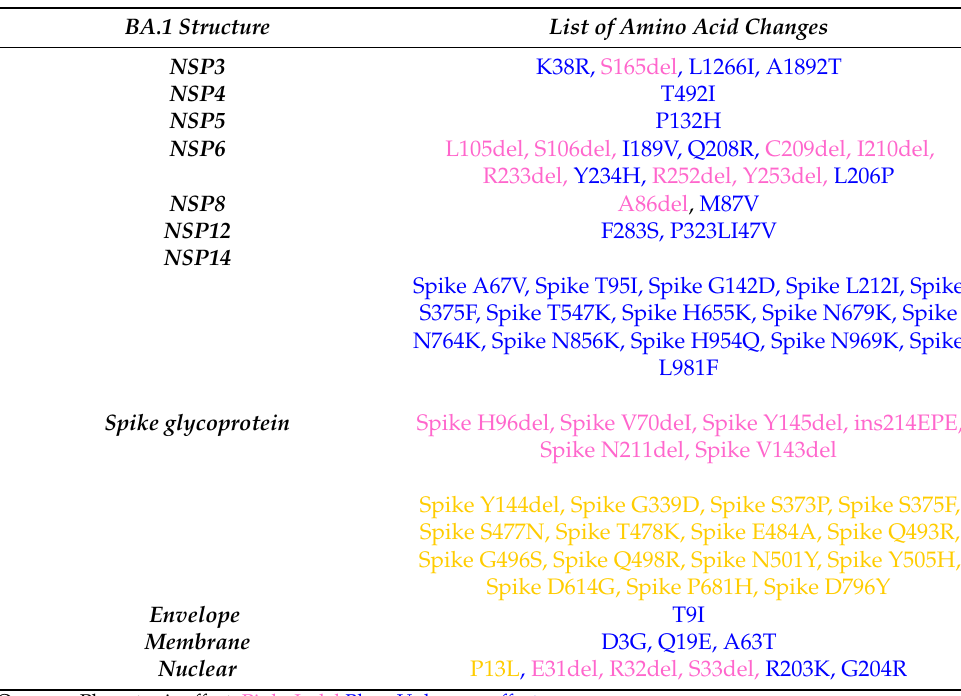
Table 2. Determination of variations in the structural protein of the Omicron